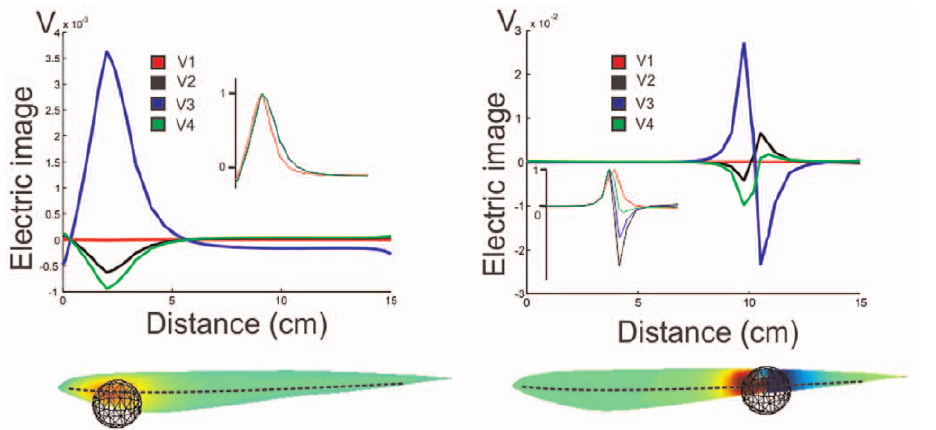
Figure 7. Images of a metal sphere. Left : when the sphere is in the head region; Right : when it is close to the place where the field at the peak of V 3 is zero. Top: images calculated along a line through the horizontal plane by the center of the sphere. Insets show the normalized images. Bottom: images on the skin of the fish, indicating the position of the sphere is shown by its image. The broken line on the fish indicates the line along which top images were plotted.